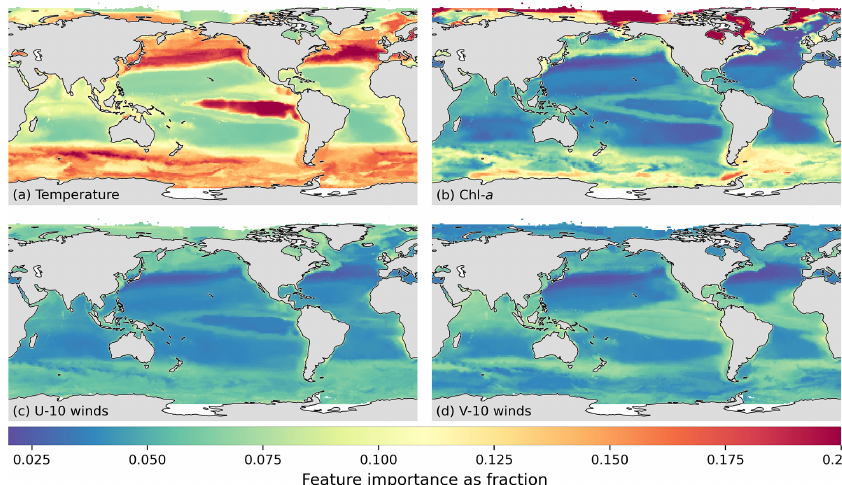
Figure A3. Feature importances determined by gradient boosted decision trees for p CO 2 predictions. A subset of four proxies are shown for the months of June, July, and August. The feature importances allow one to make informed decisions about the inclusion or exclusion of proxy variables. Here, temperature (a) is one of the more important features, Chl a is most important in the high northern latitudes, and the U and V components of the winds are important along the coastal regions, particularly the eastern boundary upwelling systems.